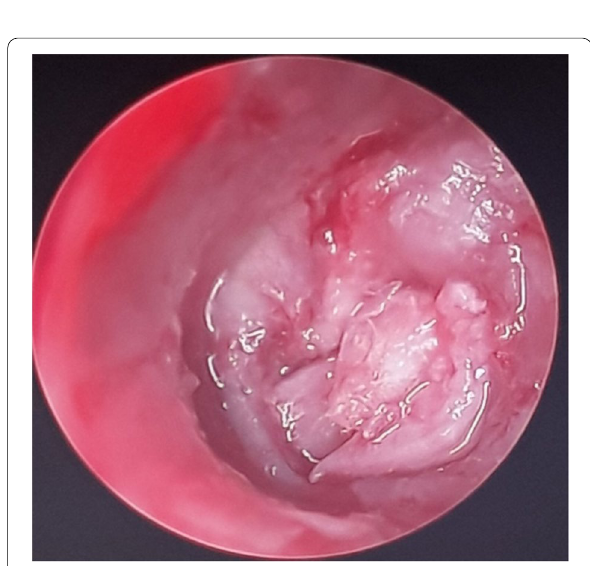
Fig. 3 The cartilage graft sealing the tympanic membrane perforation